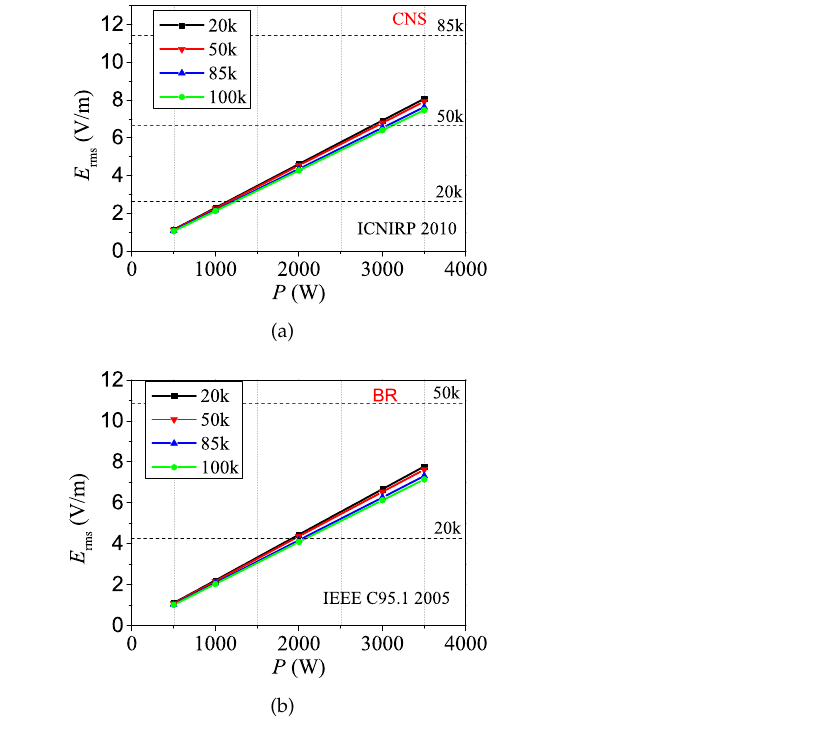
Figure 6. Curves of the internal E-field strength of human body changes with output power and frequency based on the ( a ) ICNIRIP 2010 standard and ( b ) IEEE C95.1 standard.